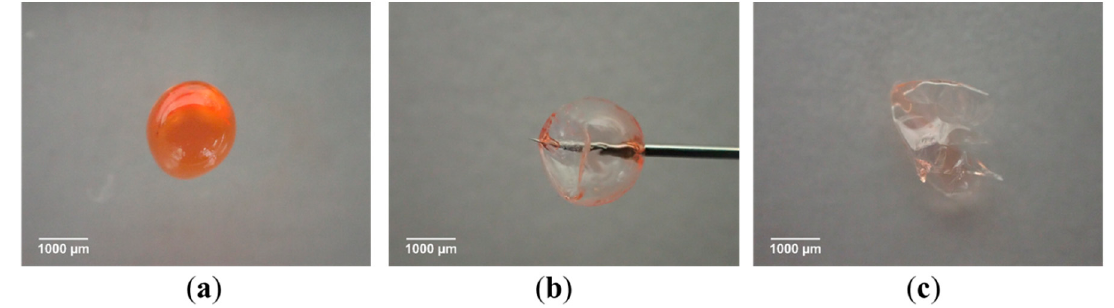
Figure 7. Images of a liquid core calcium alginate microcapsule prepared by vibration nozzle technique (prepared by Büchi B-390 Microencapsulator) followed by coacervation: ( a ) oil-filled hollow particles, ( b ) calcium alginate shell after removal of oil core, and ( c ) calcium alginate shell cut in half (average wall thickness: 8 µm) (Images: Nikon SMZ 1000 Microscope).